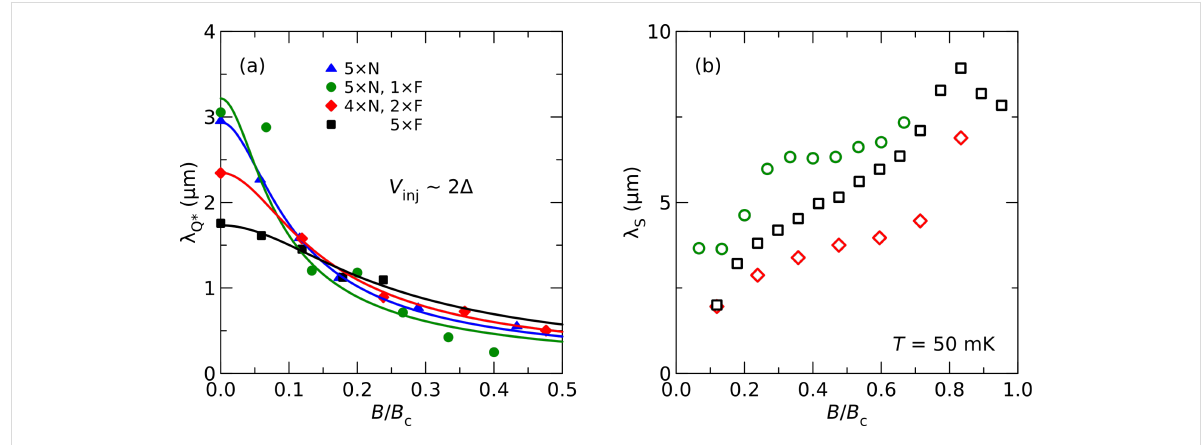
Figure 4: Charge relaxation length at a bias voltage of about 2 Δ (a) and spin diffusion length λ S (b) for different samples as a function of normal- ized magnetic field B / B c . The samples have different number of ferromagnetic (F) and normal-metal (N) contacts, as indicated in the legend. Symbols are experimental data [17,18], lines are fits explained in the text.